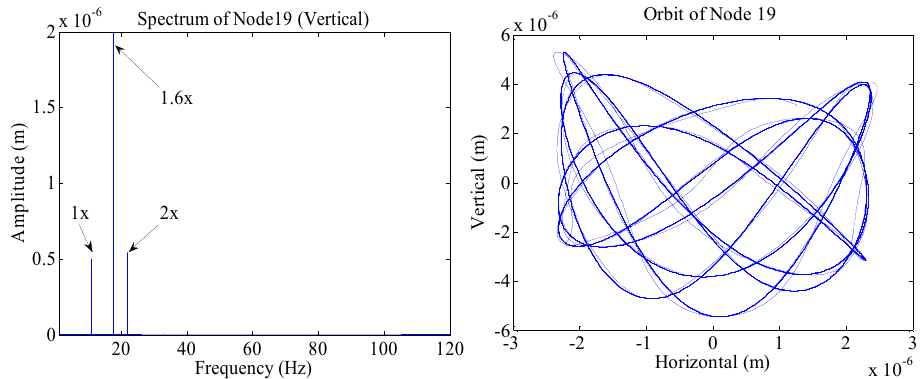
Figure 12. The spectrum and the orbit of Bearing 4 (misalignment at Bearing 3).